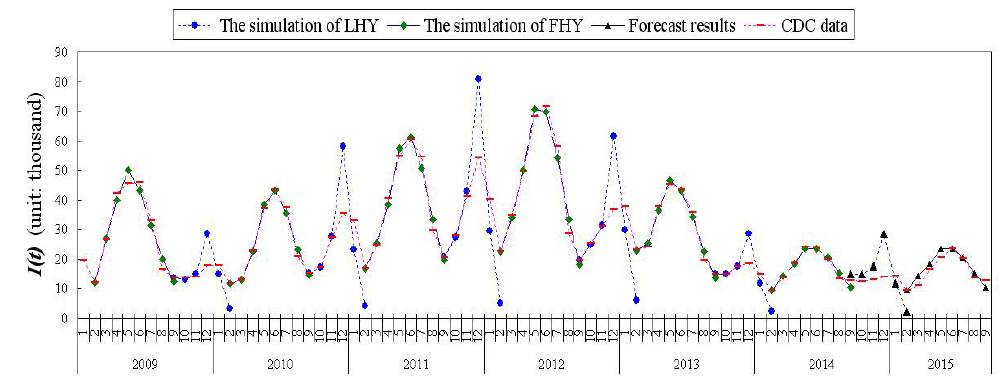
Figure 2. The comparison chart of the data of mumps in China and simulation results by model Equation